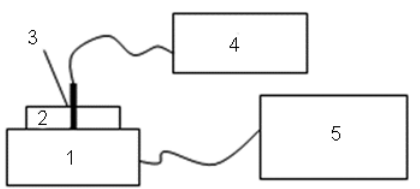
Fig. 1. The principal scheme of the one-side heating equipment that has been used for one side heating tests: 1 – the one-side heating apparatus; 2 – fragment of the tested structure; 3 – the temperature measuring equipment; 4 – the Eurotherm 401 recorder; 5 – the TR-5 controller for regulation of temperature in the heating